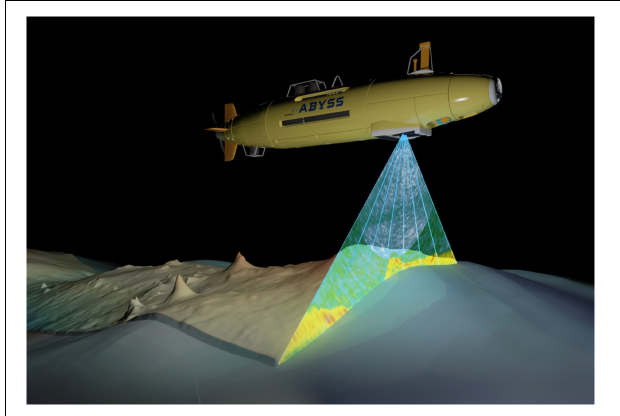
FIGURE 1 | Artistic impression of an AUV performing a deep-sea multibeam survey (courtesy of Tom Kwasnitschka/Nico Augustin, GEOMAR).